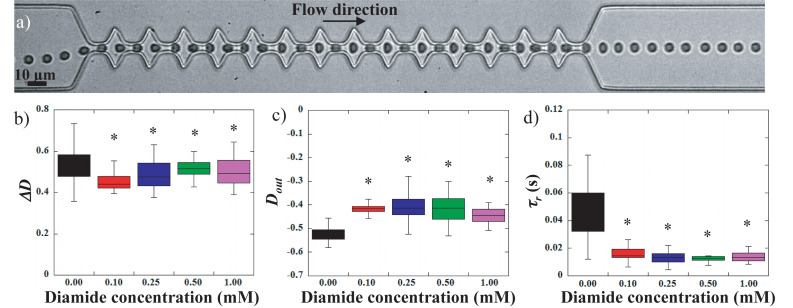
(a) sequence of deformation of a 1 mM diamide treated RBC flowing in the geometry. Evolution of (b) the amplitude of deformation ΔD, (c) the stretching at the exit Dout, and (d)
τr, the recovery time versus diamide concentration. *Different from control sample (0 mM), p < 0.05.